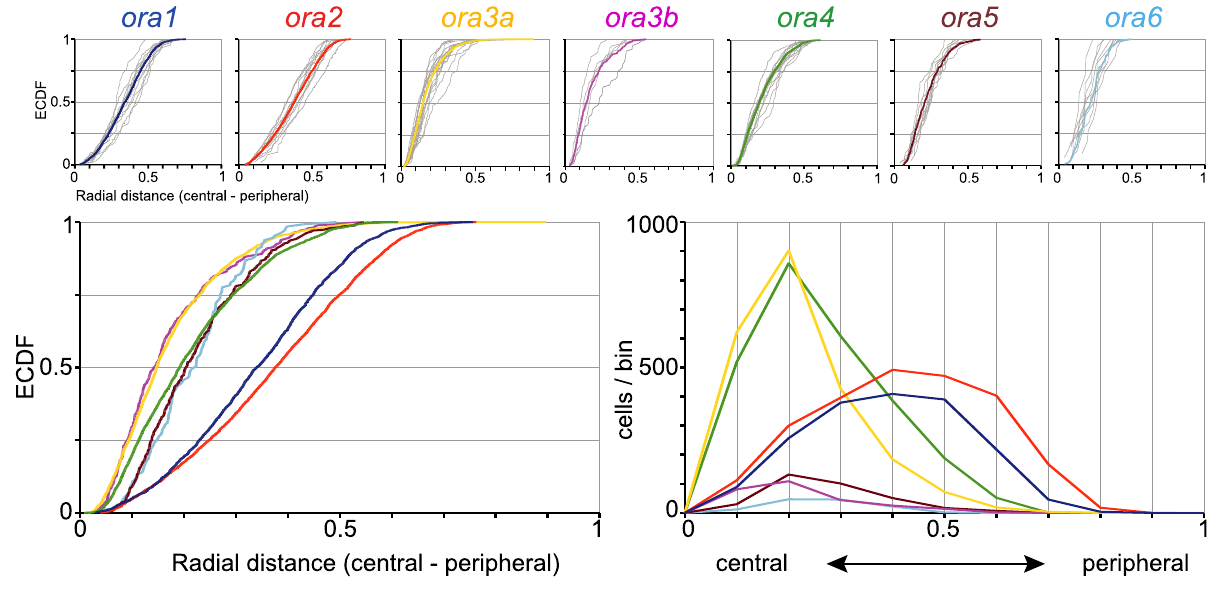
Figure 3. Quantitative analysis of radial position shows three subgroups of ora genes. Radial positions of ora - expressing cells were quantified for all seven ora genes. Complete series of sections from five to fifteen olfactory epithelia were evaluated for each ora gene. Radial position within the section was normalized to maximal radius, i.e., length of the lamella containing the respective labeled cell. Upper row: The resulting distributions of relative radius (from 0, innermost to 1, outermost) are shown unbinned (ECDF). Light grey curves represent the distribution for individual olfactory organs, colored curves represent the cumulative distribution for the respective genes. The color code for the ora genes is the same as in later figures to facilitate comparisons between different positional parameters. Lower row: Overlay of the seven distributions shown individually in upper row, both as ECDF (left panel) and histogram (right panel). Different genes exhibit different centers-of-gravity (mean) and different skewness. Note a segregation in three groups, with ORA3a and ORA3b in a central group, ORA1 and ORA2 in a peripheral group and the remaining three receptors in an intermediate